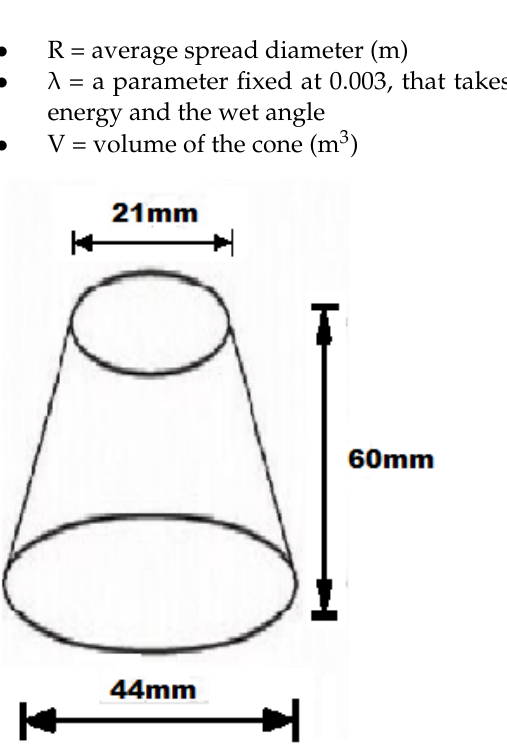
Figure 2. Dimensions of the mini-slump cone.